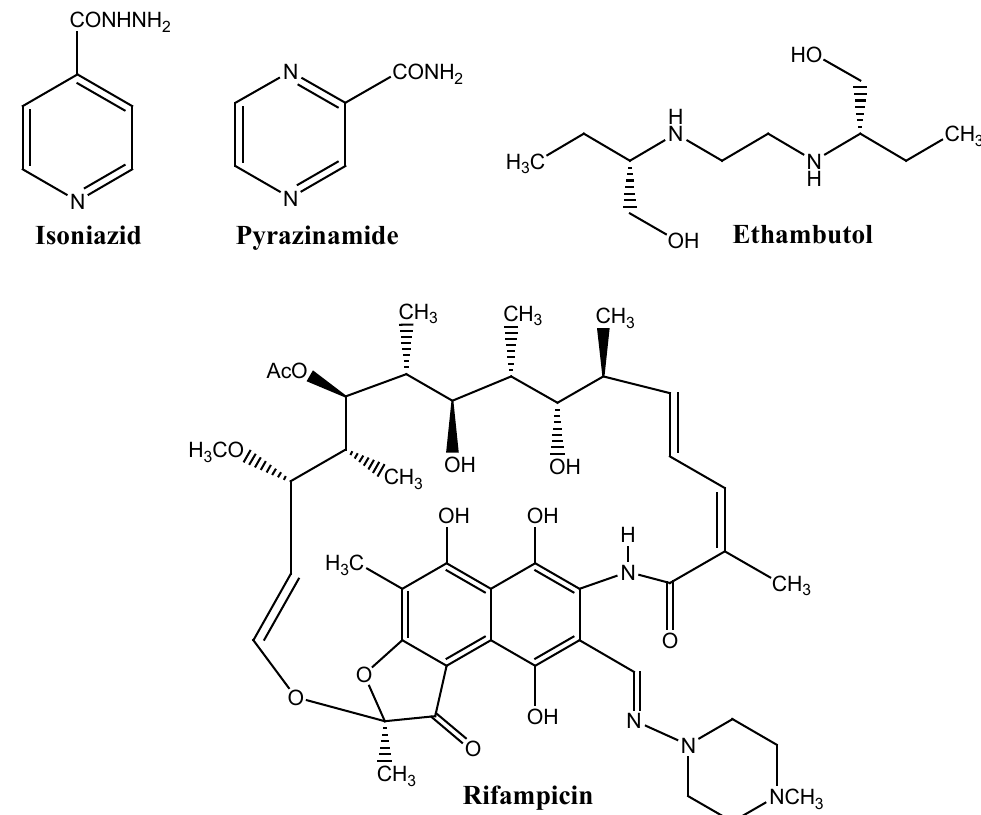
Figure 1. Chemical structure of the first choice pharmaceuticals for TB